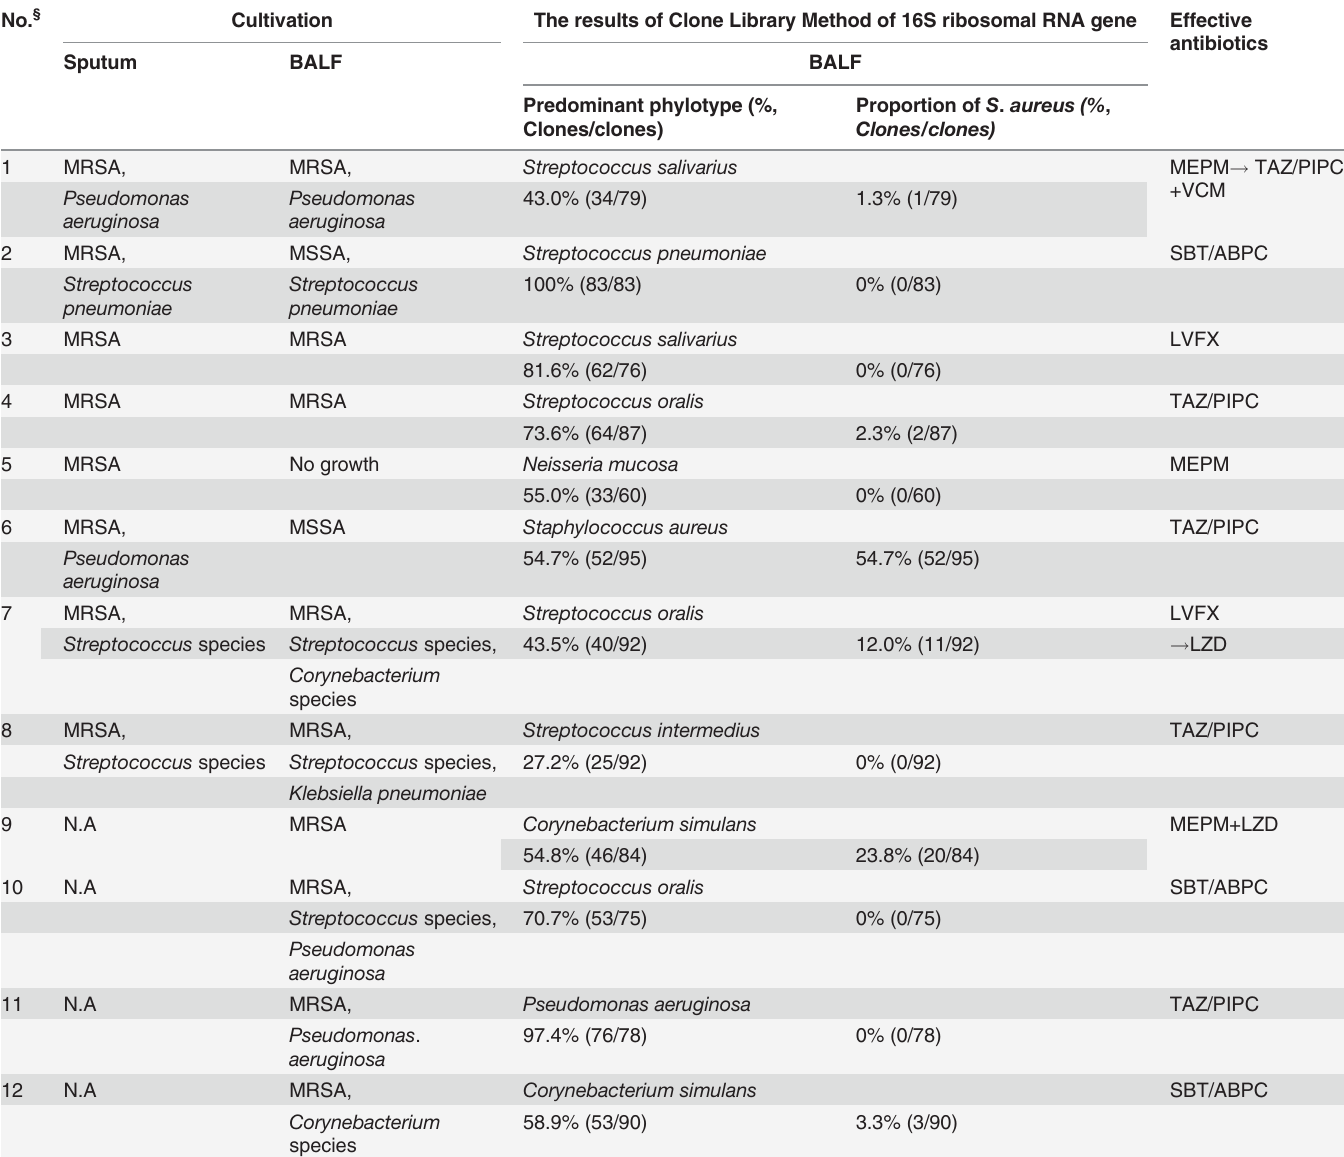
Table 4. Results of the molecular method and antibiotics efficacy in patients with positive cultivation of MRSA. No.